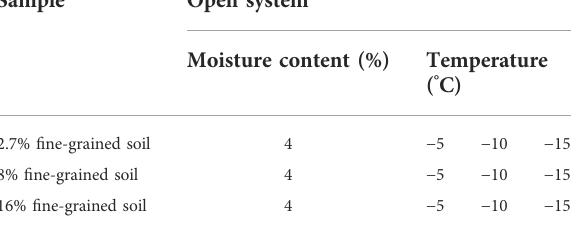
TABLE 3 Test scheme under the opened